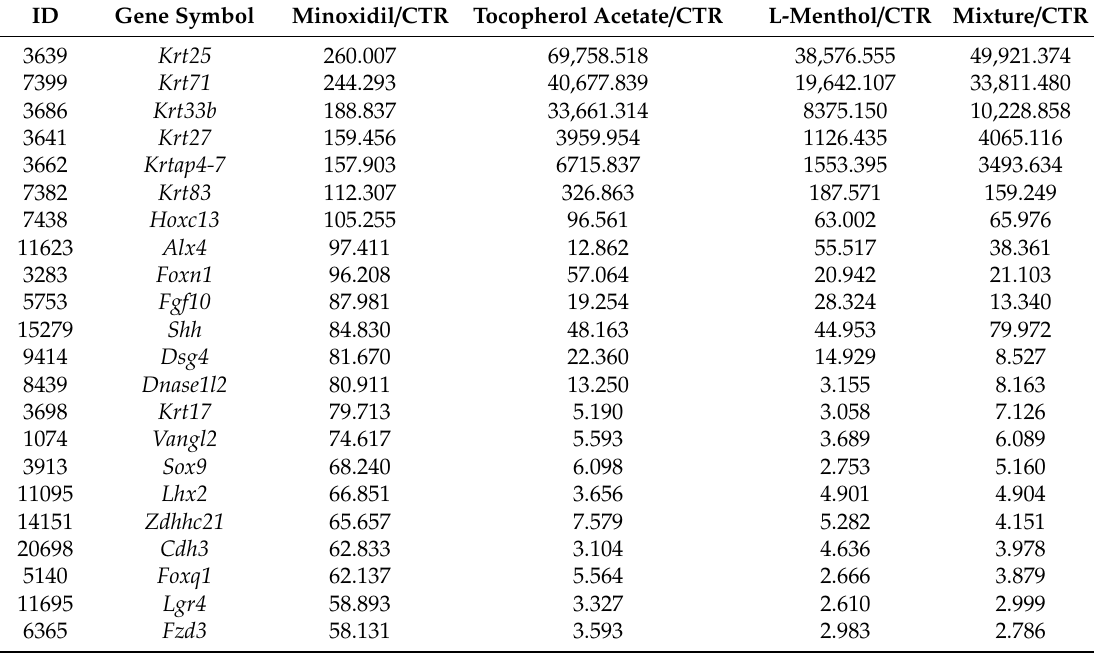
Table 1. Top 22 most upregulated genes in the minoxidil group were also upregulated at the highest rate in tocopherol vs. CTR and L-menthol vs. CTR. CTR =